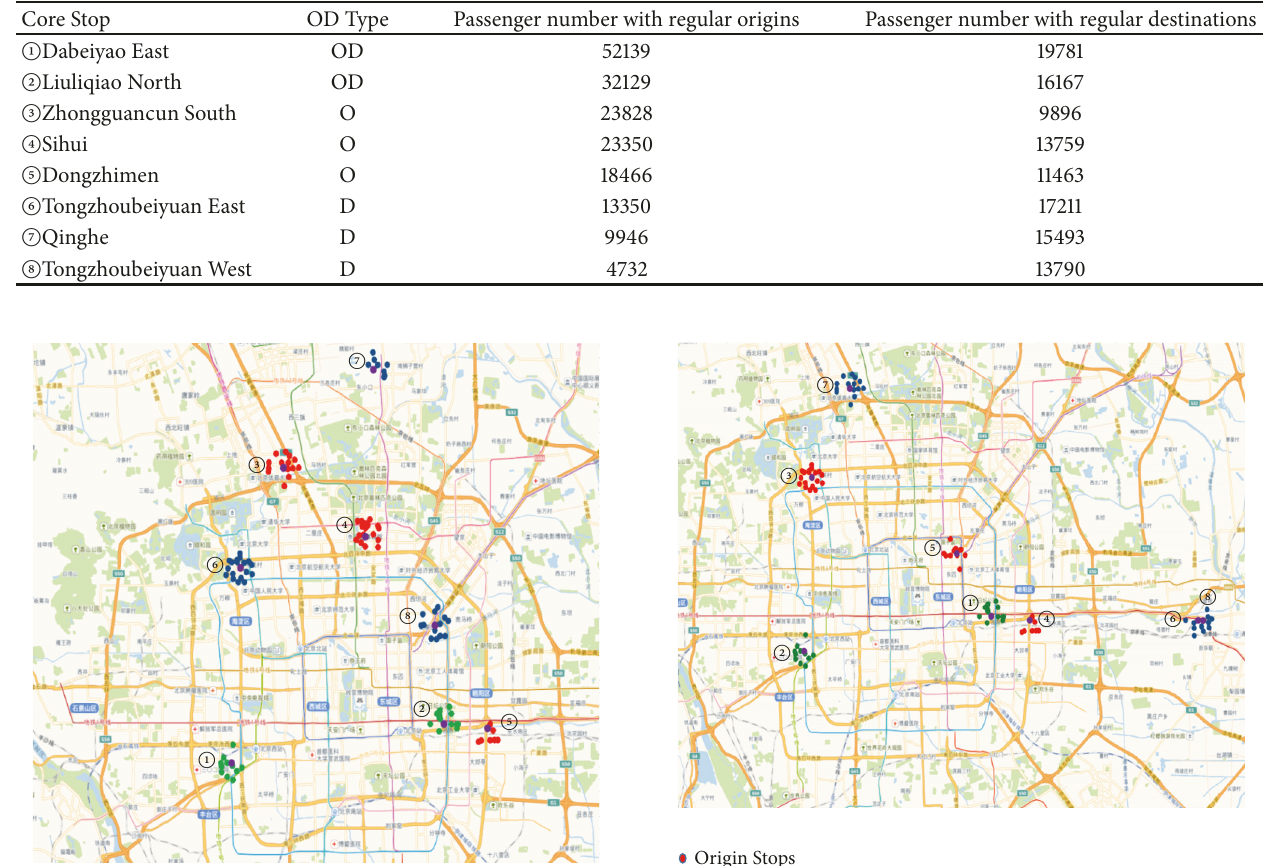
Table 4: Detail data for the top five origin areas and the top five destination areas in the evening.